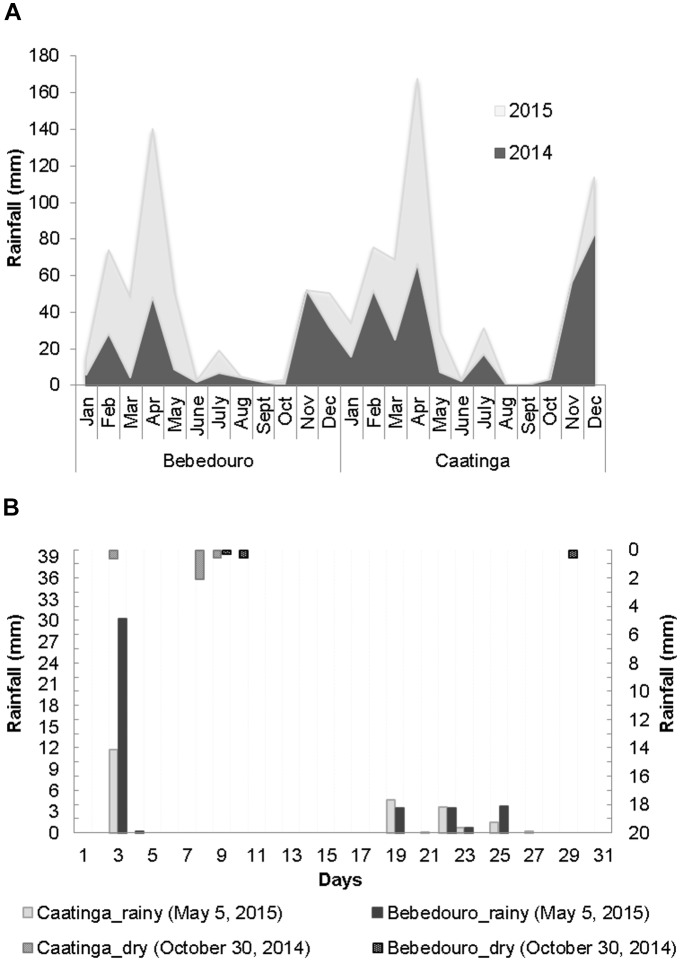
(A) Monthly rainfall distribution at the CEF and BEF stations of the Caatinga during the years 2014 and 2015. (B) Daily rainfall data (0–30) during soil sampling on 5 May and 30 October, corresponding to the rainy (main axis) and dry (secondary axis) periods, respectively. The data were obtained from automatic meteorological stations of EMBRAP9A.